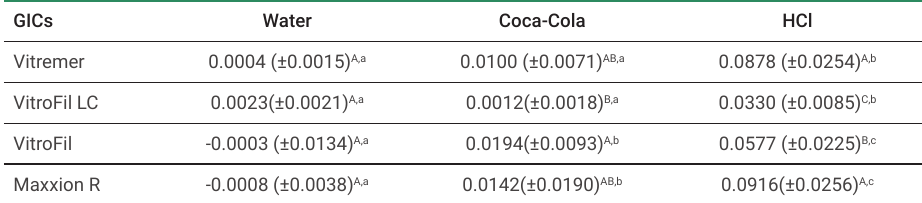
Table 2. Mean (SD) values of solubility (µg/cm 3 ) of glass ionomer cements (GIC) after challenges.